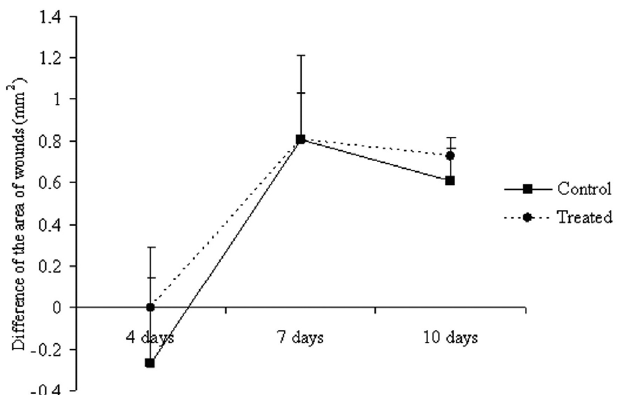
FIGURE 3 - Differences between the initial and final areas (mm 2 ) of cutaneous wounds treated with ointment containing 1% ethyl-acetate fraction from stem bark of S. adstringens . Mean ± S.D. (n = 4), *P<0.05 compared to the